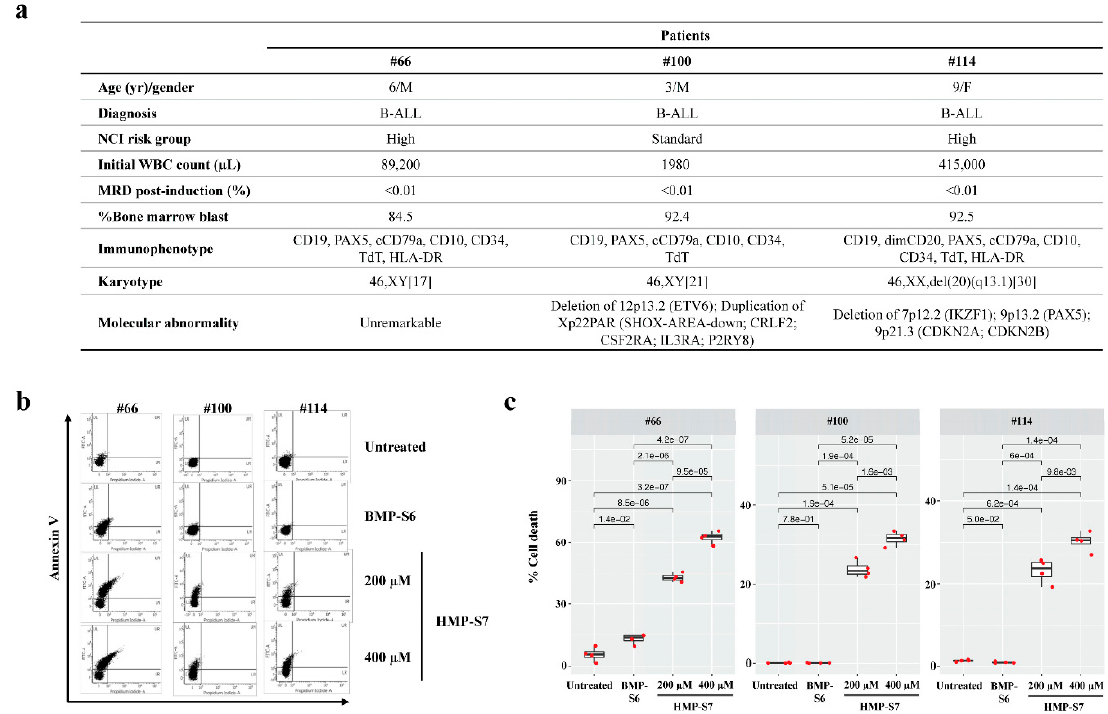
Figure 7. HMP-S7 induced patient-derived leukemic cell death ex vivo. Bone-marrow-derived lymphoblasts were collected from three leukemic patients and were processed as described in “Materials and Methods” section. ( a ) Demographic data of three leukemic patients. Patient-derived lymphoblasts were treated with two doses of HMP-S7 or with BMP-S6 (a positive control from previous experiments); ( b ) flow cytometric analysis with annexin V/PI co-staining at 72-h post- treatment. Patient-derived leukemic cells were treated with 200 and 400 µ M HMP-S7, while 200 µ M BMP-S6 was included for comparison; ( c ) % cell death including the upper left, upper right, and lower right quadrants of flow cytometric data ( n = 4 replicates per condition). Abbreviations: B-ALL, B-cell acute lymphoblastic leukemia; F, female; M, male; MRD, minimal residual disease; NCI, National Cancer Institute; WBC, white blood